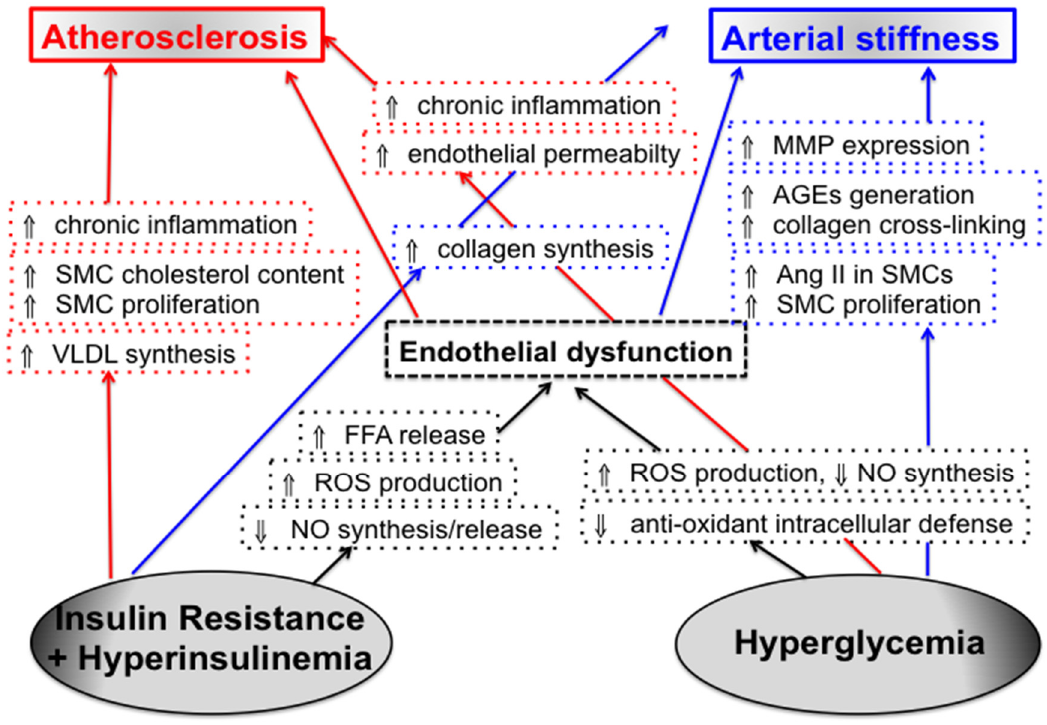
Figure 1. Pathophysiologic mechanisms through which insulin resistance and hyperglycemia may affect the arterial wall.